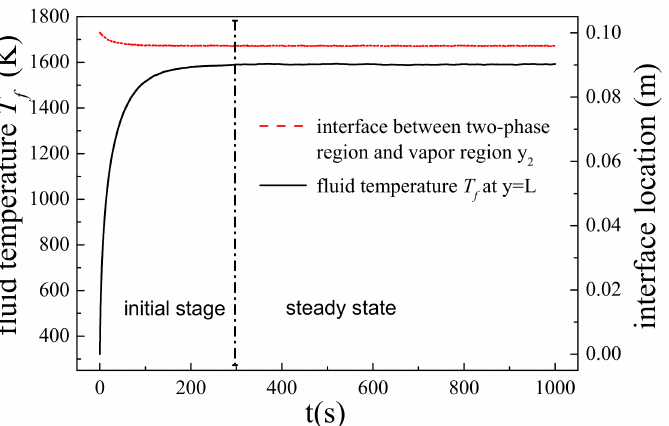
Figure 3. The transient variations of fluid temperature at the hot side and phase interface position y 2